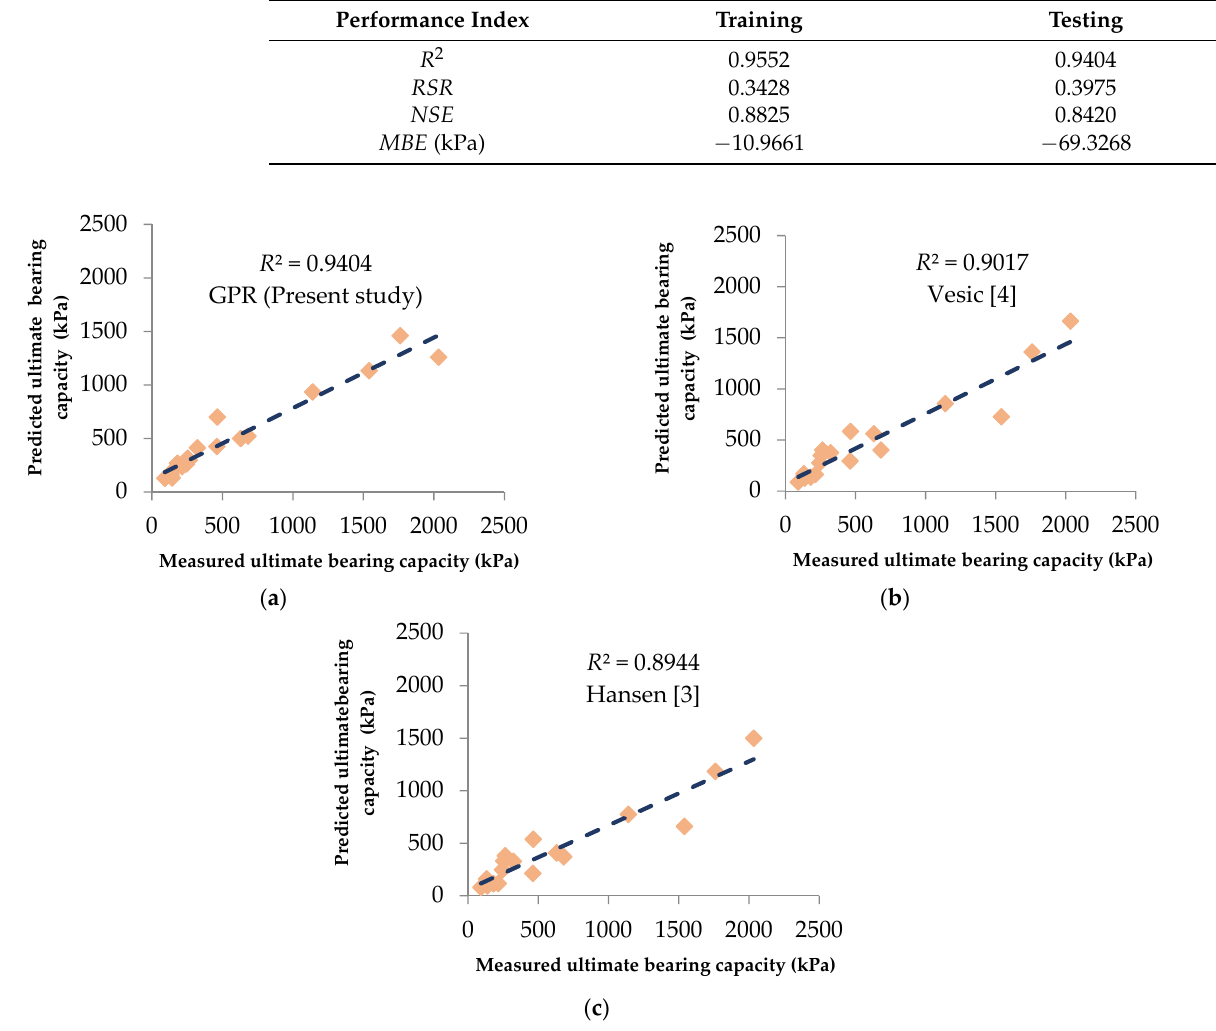
Figure 2. Scatter plot presenting the actual UBC values versus the predicted UBC on the testing dataset: ( a ) in GPR model (this study); ( b ) in Vesic [4]; ( c ) in Hansen [3]. Table 5. Performance statistics of bearing capacity